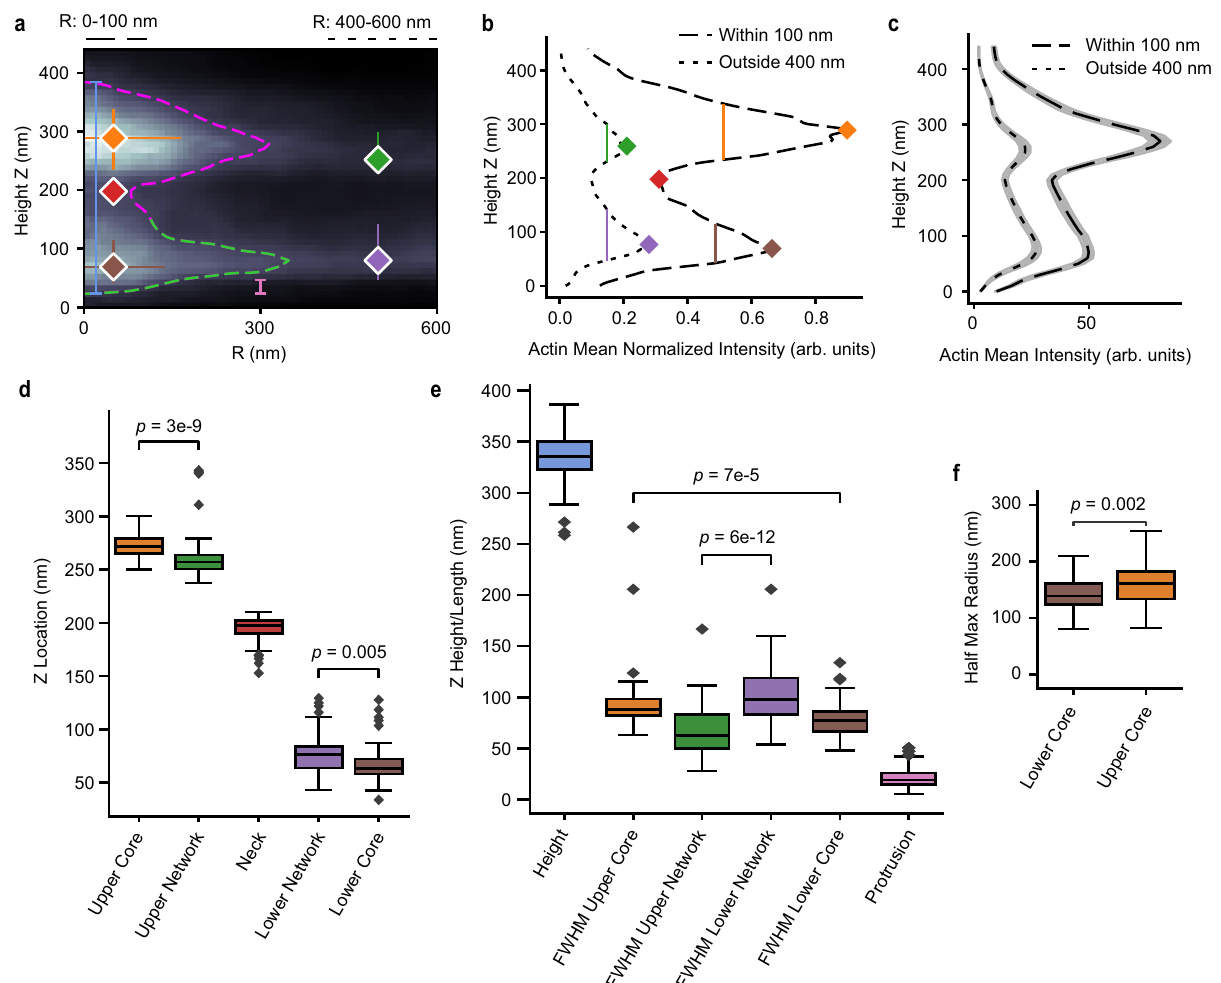
Fig. 5 | Individual podosome features quanti fi ed from iPALM radial averaging heatmaps. a A radial averaging heatmap for an individual podosome with quan- ti fi ed features. Blue line is podosome height, pink line is protrusion length. Red diamond is the neck location. The location (diamond), Z full-width half-max (FWHM, vertical line), and R half-max radii (horizontal line, only for the cores) are shown for orange=upper core, brown=lower core, green=upper actin network, purple=lower actin network. b For the podosome in a , mean intensity versus height plot for portions within 100nm of the center (dashed) and beyond 400nm (dotted). Peaks, troughs, and FWHM shown correspond to a . c Mean intensity versus height plots of distributions within 100nm and outside 400nm ( n =72